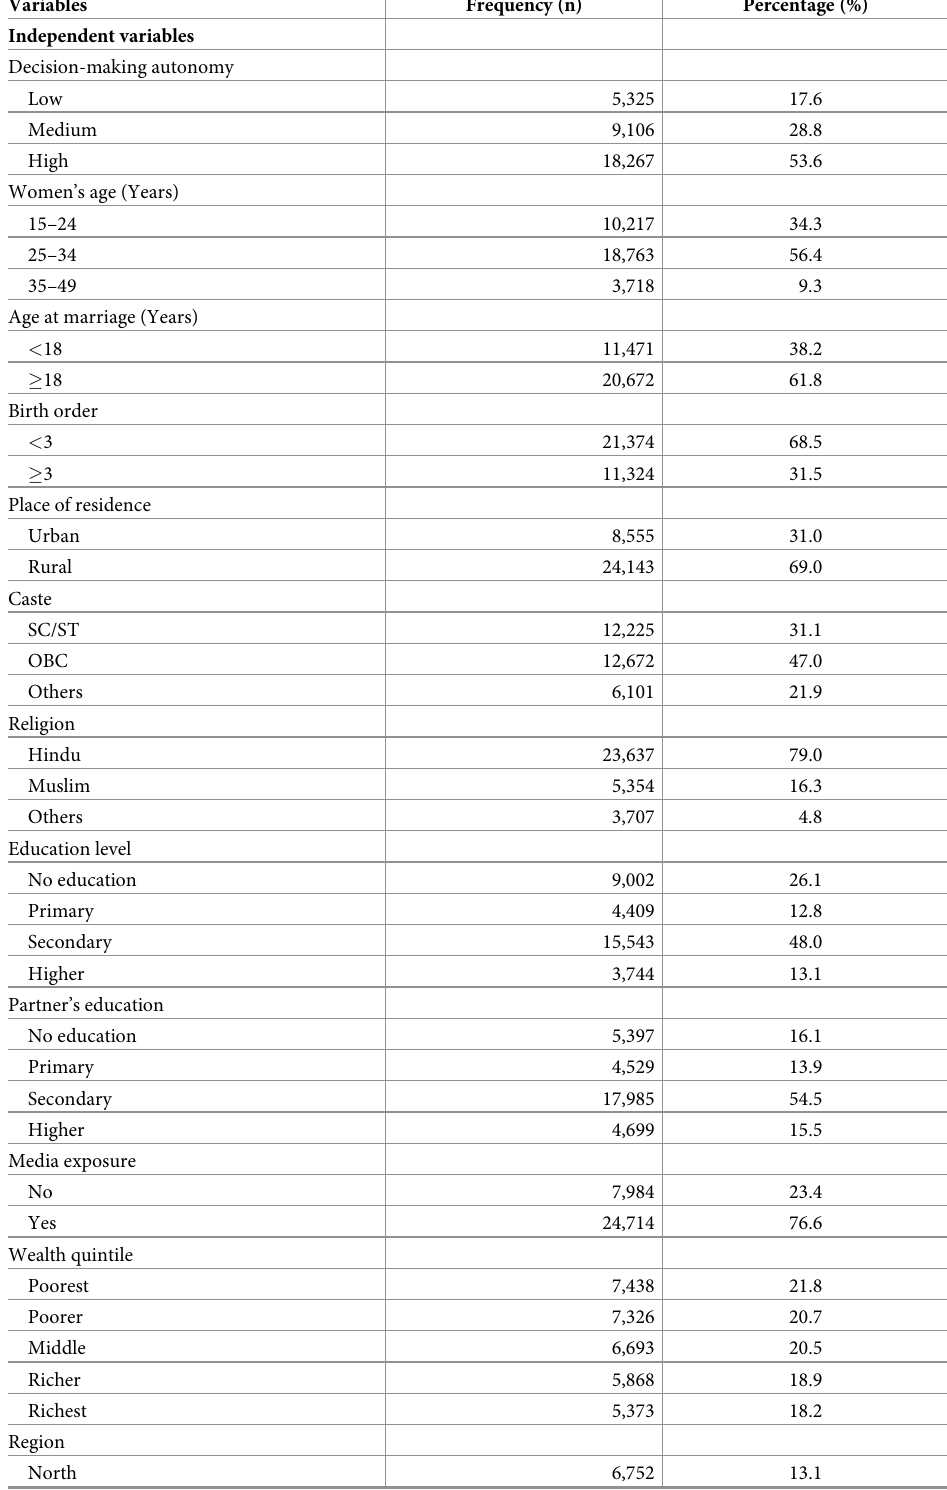
Table 1. Descriptive statistics of the study participants (n =